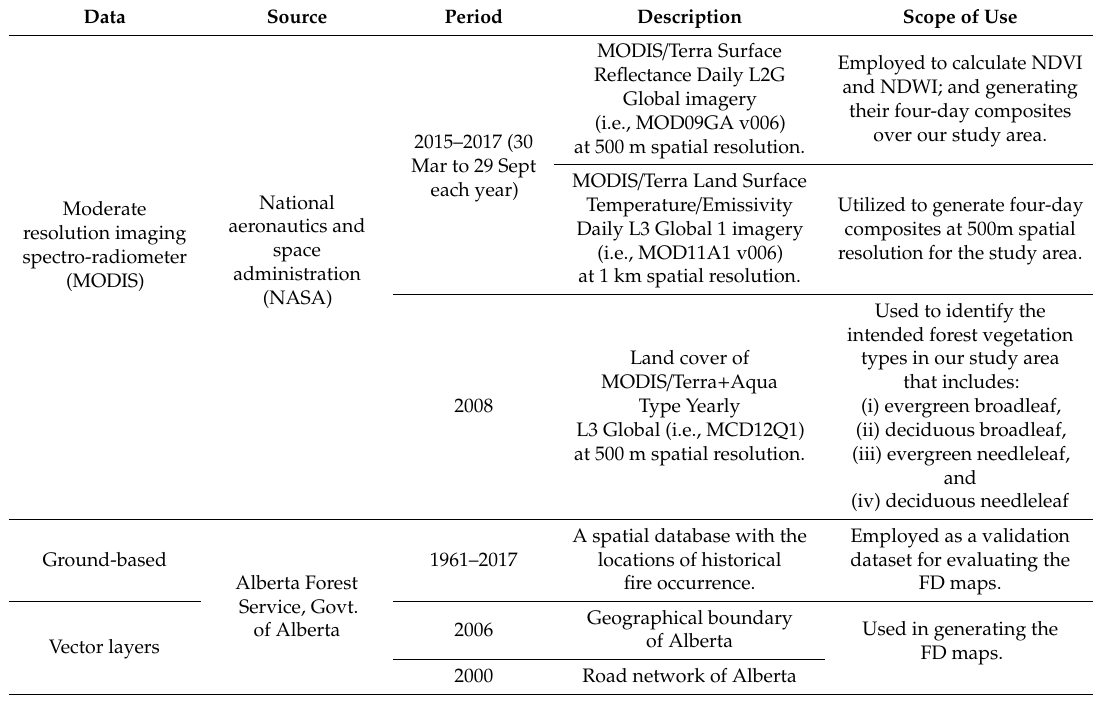
Table 1. Description of the di ff erent datasets that were used in the study to fulfill the